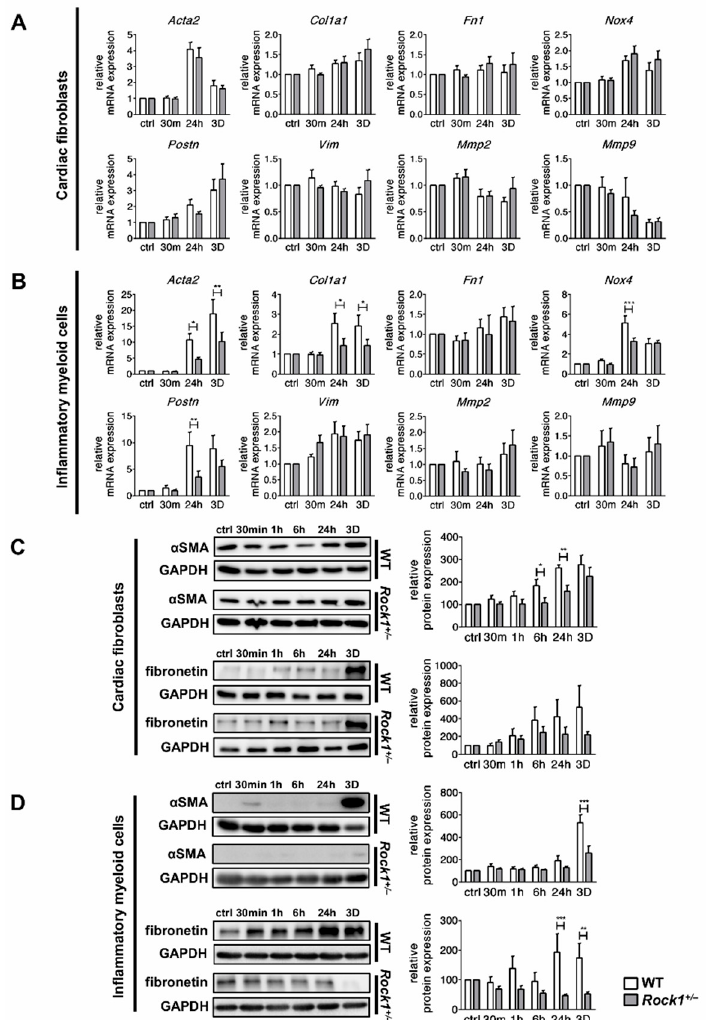
Figure 5. ROCK1 differentially regulates profibrotic products in cardiac fibroblasts and in inflammatory myeloid cells. Panels ( A ) and ( B ) show relative expression of selected profibrotic genes in wild-type and Rock1 +/ − cardiac fibroblasts ( A ) (n = 6–8), and inflammatory myeloid cells ( B ) (n = 6–8), at the indicated time point following TGF- β stimulation. Gene expression was normalized to Gapdh . Panels ( C ) and ( D ) show representative immunoblots and the respective quantifications (normalized to GAPDH) of α SMA and fibronectin in wild-type and Rock1 +/ − cardiac fibroblasts (C) (n = 7), and inflammatory myeloid cells ( D ) (n = 6–9), at the indicated time point following TGF- β stimulation. Relative response to TGF- β was calculated in relation to internal untreated controls (ctrl) for wild-type and Rock1 +/ − cells. Bars represent mean value ± SEM. * p < 0.05, ** p < 0.01, *** p < 0.001 calculated with the unpaired Student’s t -test for each time point.